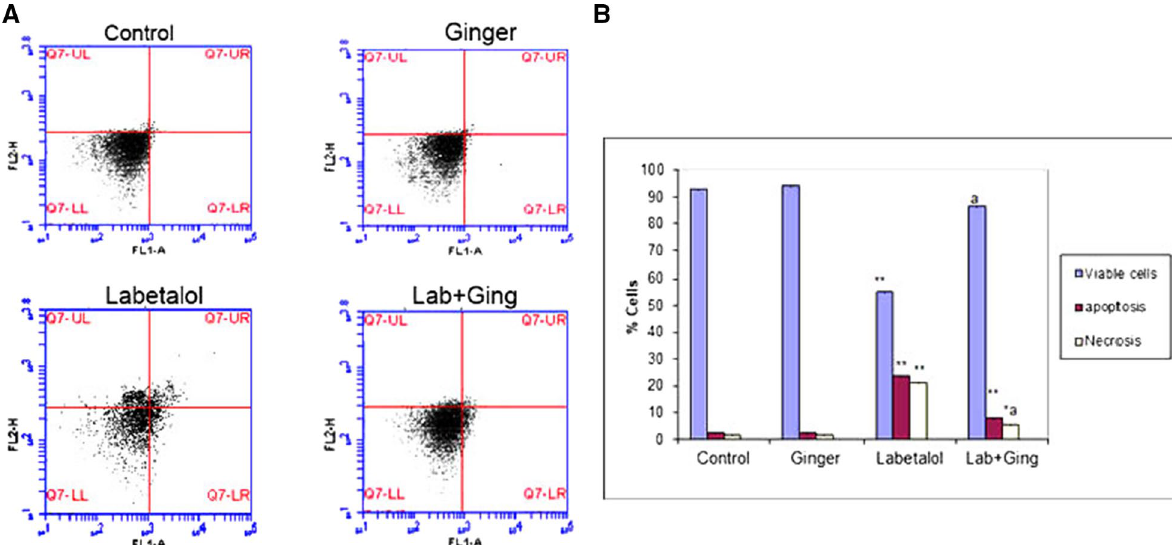
Fig. 6 Fluorocytograms of fetal hepatocytes a control; b ginger; c labetalol; d labetalol (Fl2‑H) PI‑labeled cells. The lower left portion (Q7‑LL) of the fluorocytogram (negative for both stains) shows viable cells, whereas the lower right = portion (Q7‑LR) (positive for annexin) shows early apoptotic cells, the upper right portion (Q7‑UR) (positive for both stains) shows late apoptotic cells and the upper left portion (Q7 UL) (positive for PI) shows necrosis. e Graph showing the percentage of viable, apoptotic and necrotic hepatic populations in experimental groups. Asterisks (*** P < 0.001) refer to P values compared with the control group. a compared with the labetalol